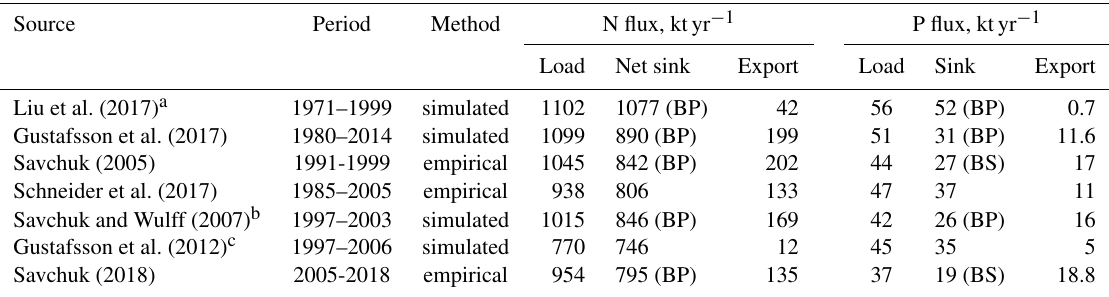
Table 1. Nitrogen and phosphorus budgets for the entire Baltic Sea, both based on observations with water fluxes reconstructed from salt budgets as well as on model results. Fluxes show loads from land and the atmosphere, the net export to the North Sea, and the biogeochemical sinks within the Baltic Sea, indicating the basin with the largest sink in brackets (BP: Baltic Proper; BS: Bothnian Sea). The sink for nitrogen is calculated as the net result of nitrogen fixation and biogeochemical sinks.